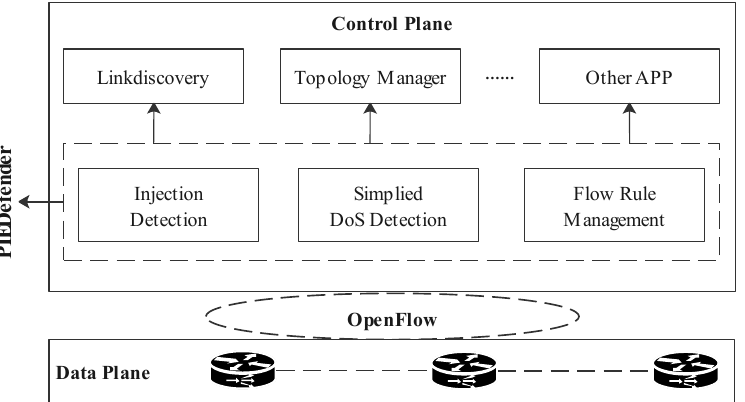
Figure 7. Architecture of the packet injection exploiting attack defender (PIEDefender).